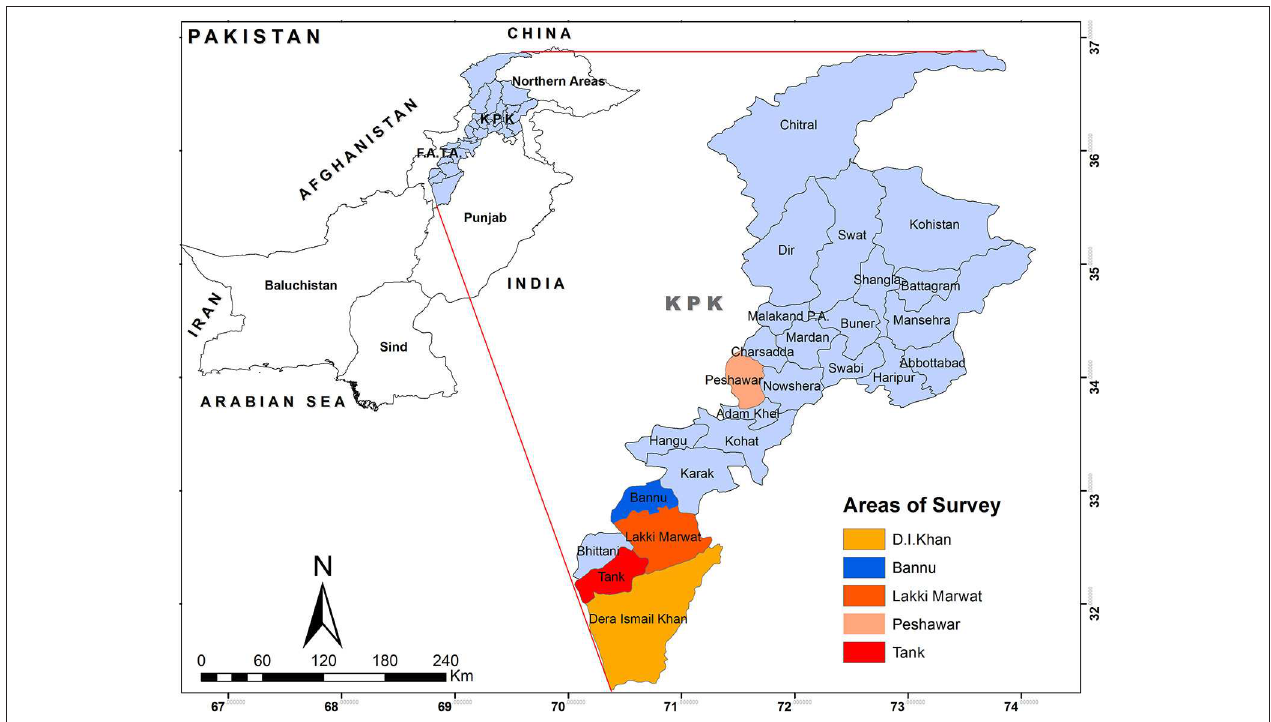
FIGURE 1 | Map of Districts visited for collection of Data. The colored areas show the districts where most Afghan refugees and IDPs were located. KPK, Khyber Pakhtunkhwa province, province adjacent to Afghanistan.